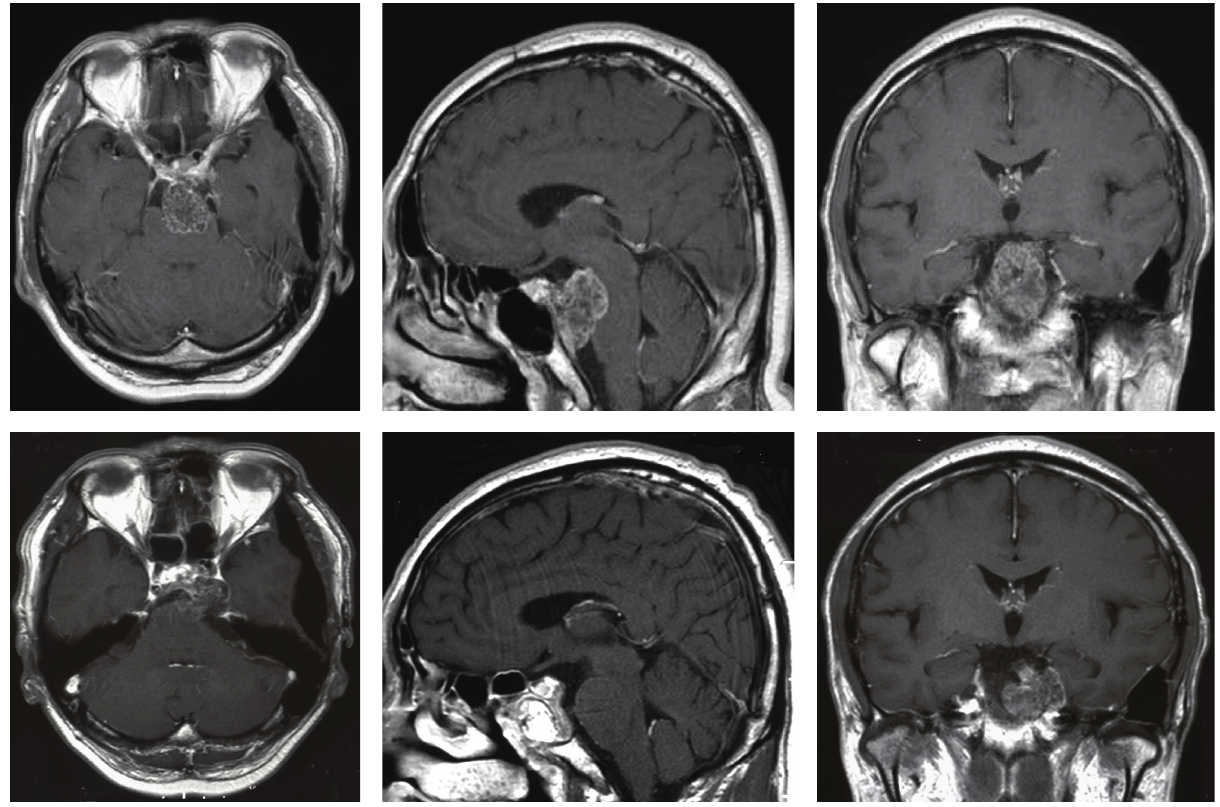
Figure 2: Case 1. Upper: MRI images 33 months after the first operation. The residual tumor is regrowing. Lower: MRI images after surgery, midline part of tumor was resected and decompressed